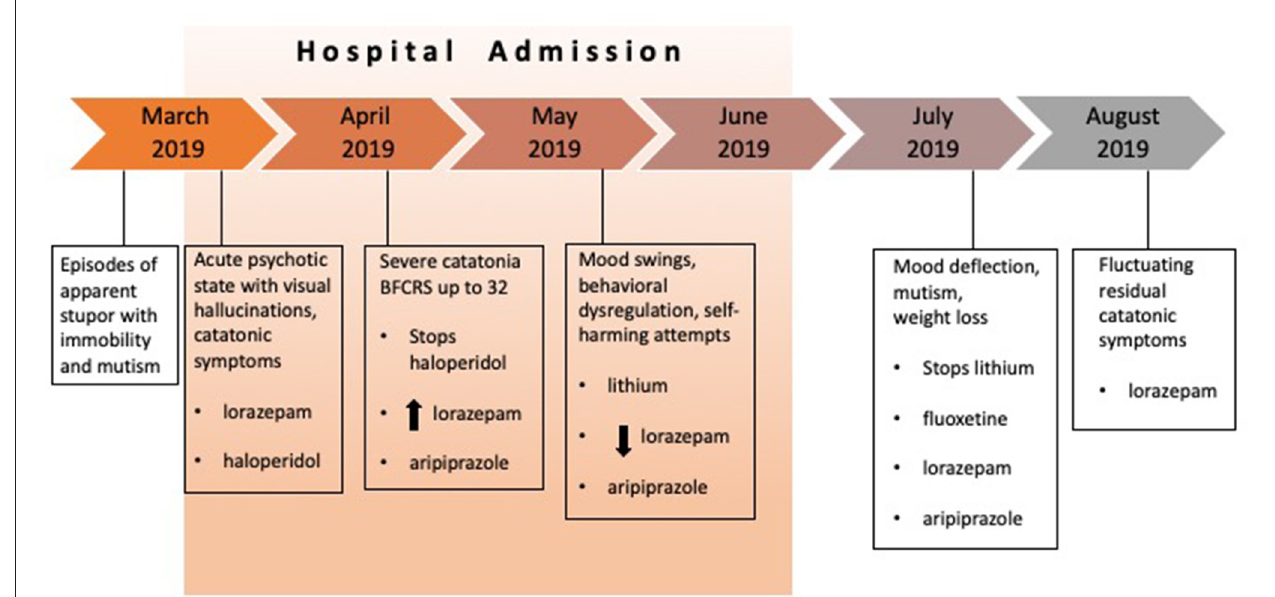
FIGURE 1 | Patient’s clinical course and